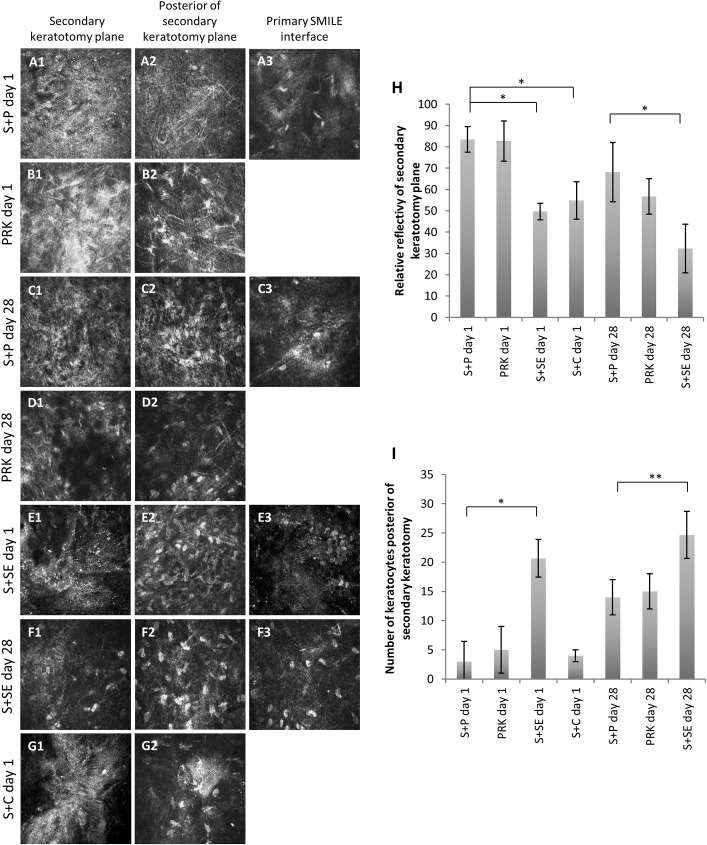
In vivo confocal micrographs of primary and secondary laser keratectomy sites and posterior plane of secondary keratectomy site captured after SMILE enhancement.Column 1 contains en-face images of secondary laser keratotomy plane after a retreatment. Column 2 shows images of in vivo confocal view 20 μm posterior of the secondary keratotomy plane. Column 3 shows images of primary SMILE interface, performed 2 weeks before the retreatment. (A) Day 1 after enhancement with PRK (S+P day 1). (B) Day 28 after enhancement with PRK (S+P day 28). (C) Day 1 after PRK only treatment (PRK day 1). (D) Day 28 after PRK only treatment. (E) Day 1 after secondary SMILE was performed anterior of the primary SMILE (S+SE day 1). (F) Day 28 after secondary SMILE was performed anterior of the primary SMILE (S+SE day 28). (G) Day 1 after excimer laser stromal ablation, following flap creation by VisuMax Circle software (S+C day 1). In this group, the flap was created from the primary SMILE cap incision; hence, the secondary keratotomy site overlapped the primary SMILE cap interface. (H) Bar graph showing mean reflectivity of the secondary laser keratotomy site after each treatment method. (I) Bar graph showing mean number of keratocytes at 20 μm posterior of the secondary keratotomy site after each treatment method. Resulting reflectivity levels and number of keratocytes were analyzed using one way ANOVA and a post hoc Tukey comparison procedure. *p<0.001 and **p<0.05.